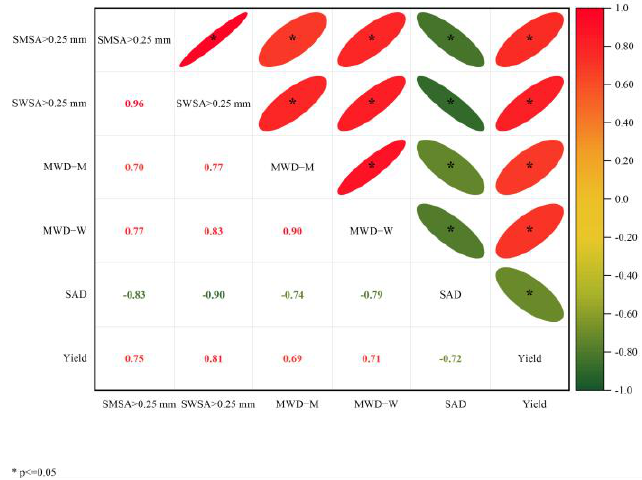
Figure 11. Correlation analysis between soil aggregate parameters and alfalfa yield in alfalfa-jujube tree intercropping systems. MWD of soil mechanically stable aggregates (MWD-M); MWD of soil water-stable aggregates (MWD-W); soil aggregate destruction rate (SAD); mechanically stable soil macro-aggregates (SWSA > 0.25 mm); water-stable soil macro-aggregates (SMSA > 0.25 mm).